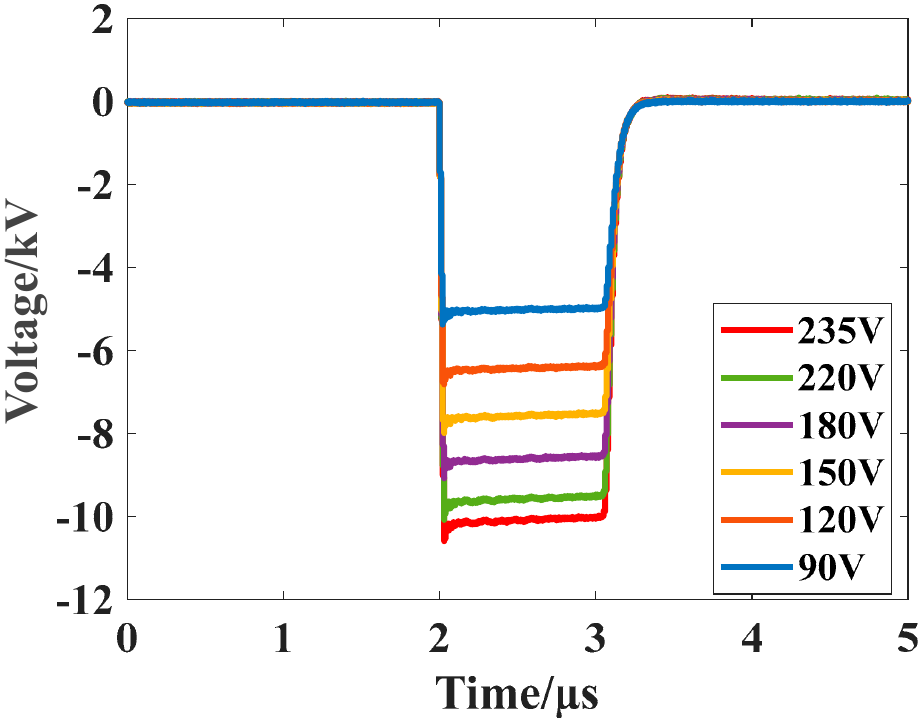
Figure 12. Output pulse waveform at di ff erent input voltages.